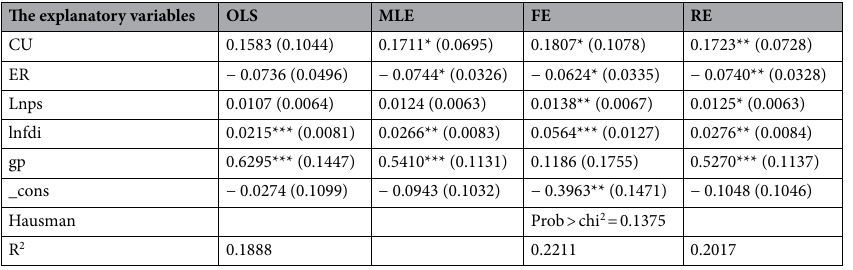
Table 3. Panel regression results. ***, ** and * respectively indicate that the parameter estimation is significant at the levels of 0.01, 0.05, and 0.1.